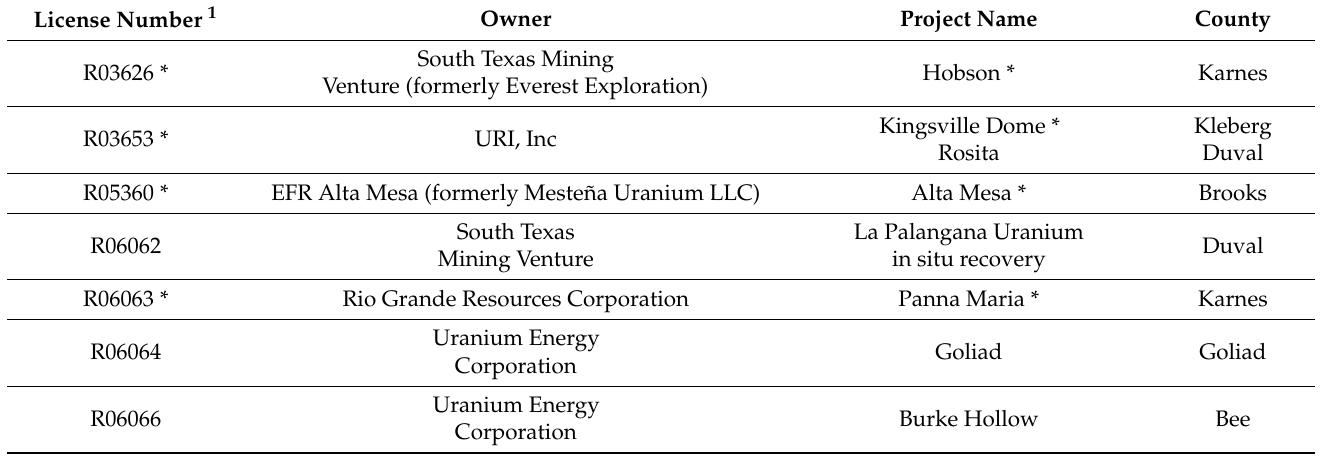
Table 1. License numbers and owners, project name, and county of facilities licensed to handle uranium in Texas as of December 29, 2021. Information obtained from the Texas Commission on Environmental Quality. (* indicates the licensee and facility are authorized to process ion exchange resin to yellowcake; locations shown on Figure